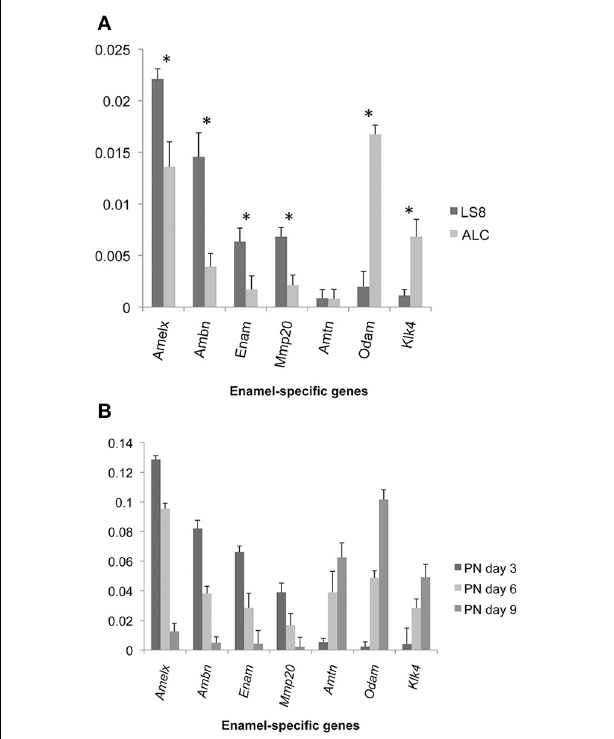
FIGURE 1 | Expression of enamel-specific genes in LS8 and ALC cells, and mice first molars at post natal (PN) days 3, 6, and 9. (A) Results of real-time PCR analyses for LS8 and ALC. The expression of each enamel-specific gene was compared within the two cell lines, and normalized to β -actin. mRNA transcript levels were compared between LS8 and ALC for Amelx, Ambn, Enam, Mmp20, Amtn, Odam, and Klk4. Average expression levels, and standard error of deviation, were calculated from seven independent real-time PCR amplifications (each run in triplicate; n = 7). Expression levels relative to Actb expression are graphed. With the exception of Amtn, there was a statistically significant difference in expression ( p < 0 . 05) between both cell lines. (B) The expression of each gene with the enamel genes is compared from three stages